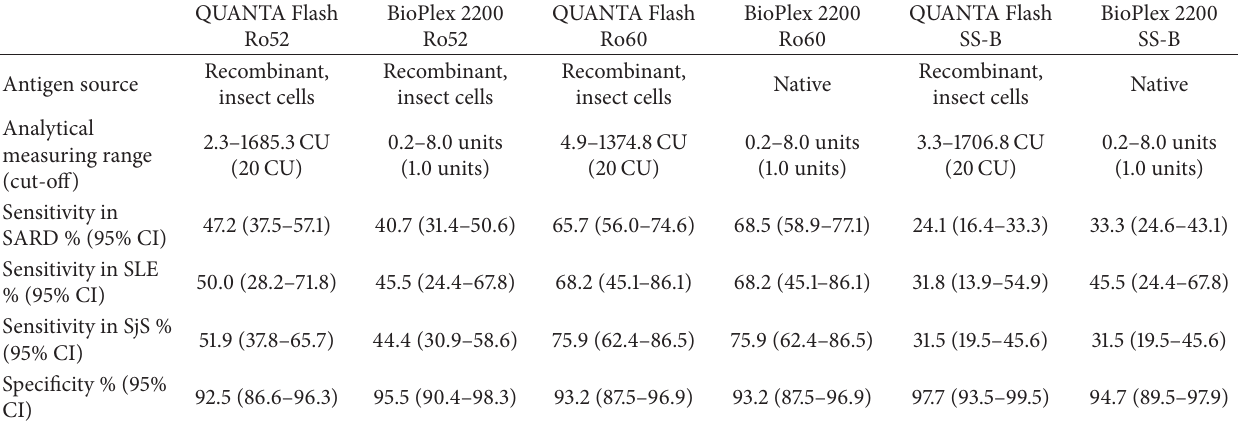
Table 1: Sensitivities and specificities of the different assays in different diseases.